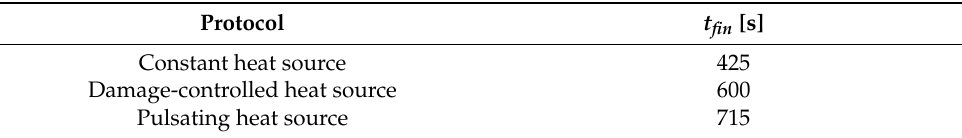
Table 3. Different treatment durations for the three evaluated